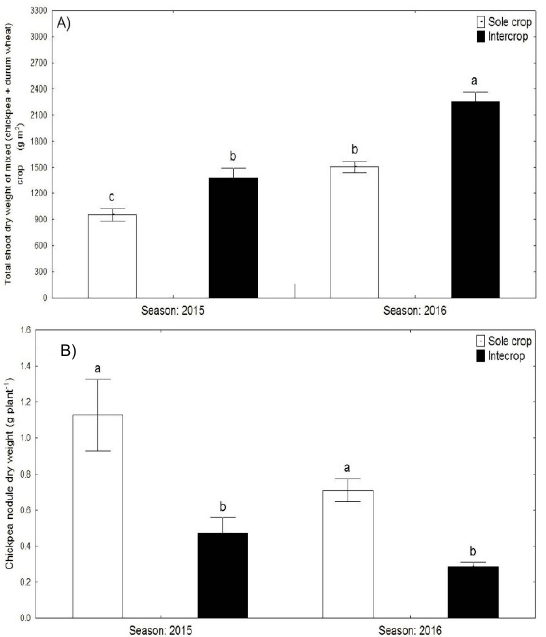
Figure 2. Total shoot dry weight (chickpea + wheat) per land area ( A ) and nodule biomass ( B ) as intercrops or sole crops in 2015 and 2016. Data are means and SE of 25 plants harvested at 120 days after sowing. Bars with the different letters compare cropping systems and years within a crop and are significantly different at p < 0.05.